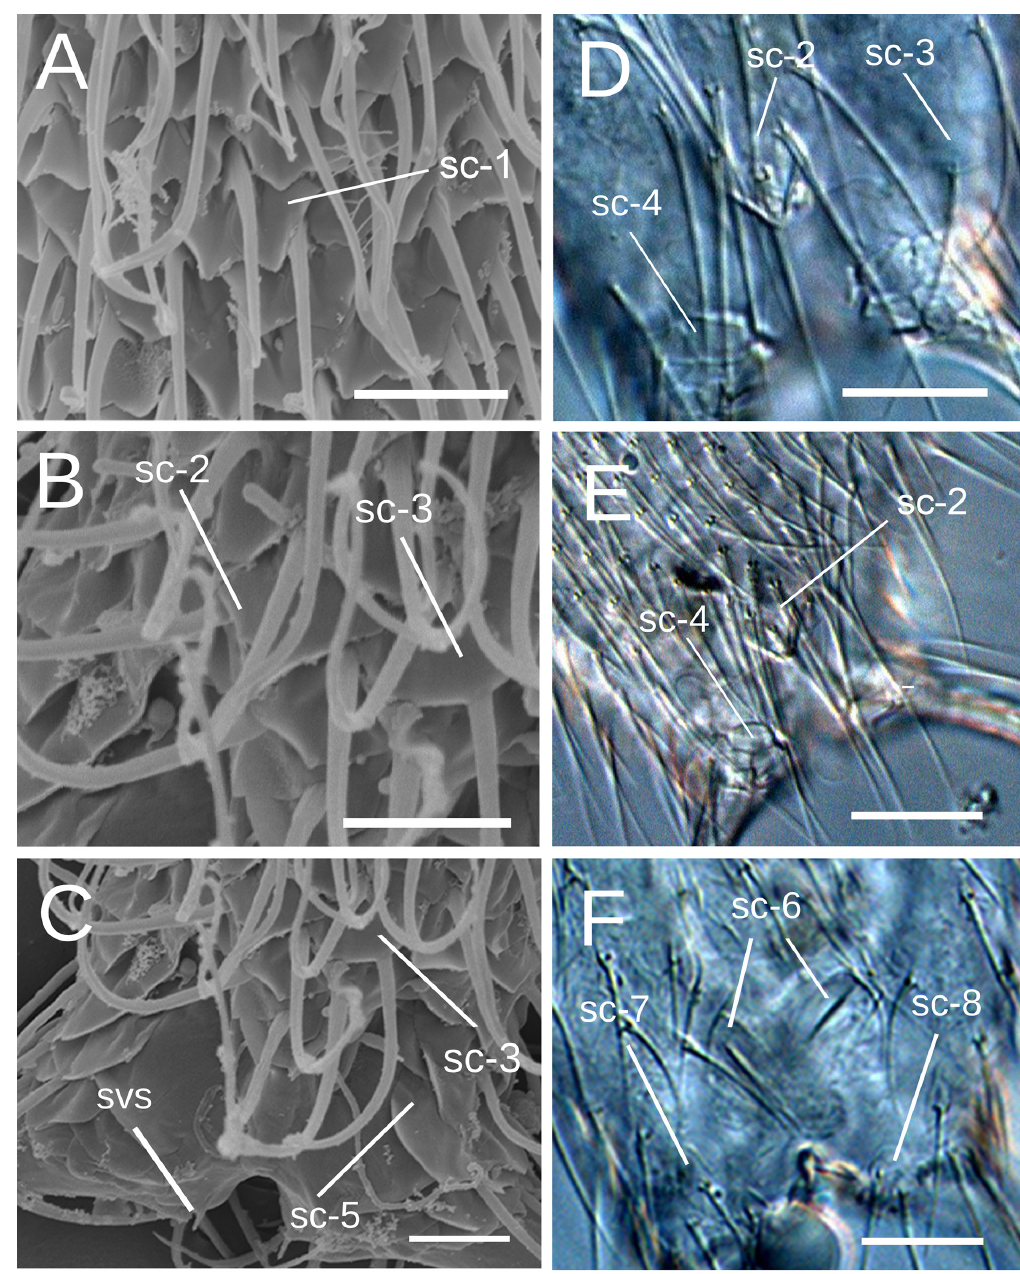
Fig. 5. Close-up of the different types of scales described for Polymerurus insularis sp. nov. A–C . Paratype (ZUEC GCH 59). D, F . Holotype (ZUEC GCH 55). E . Paratype (ZUEC GCH 56). A–C . Scanning electron microscopy. D–F . Light microscopy – DIC. A . Detail of a section of the dorsal middle trunk, showing the most common type of scale, Type 1 , with emphasis on its characteristic shape. B . Detail of a section of the dorsal posterior trunk, showing Type 2 and Type 3 scales. C–E . Detail of the transition between the dorsal posterior trunk and the dorsal furca base, showing the particular scale covering of this region. F . Detail of the transition between the ventral posterior trunk and the ventral furca base, showing the particular scale covering this region. Abbreviations: sc-1 = Type 1 scales; sc-2 = Type 2 scale; sc-3 = Type 3 scales; sc-4 = Type 4 scales; sc-5 = Type 5 scales; sc-6 = Type 6 scales; sc-7 = Type 7 scales; sc-8 = Type 8 scales; svs = small ventral pair of spines. Scale bars: A–C = 5 µm; D = 10 µm; E = 15 µm; F = 10